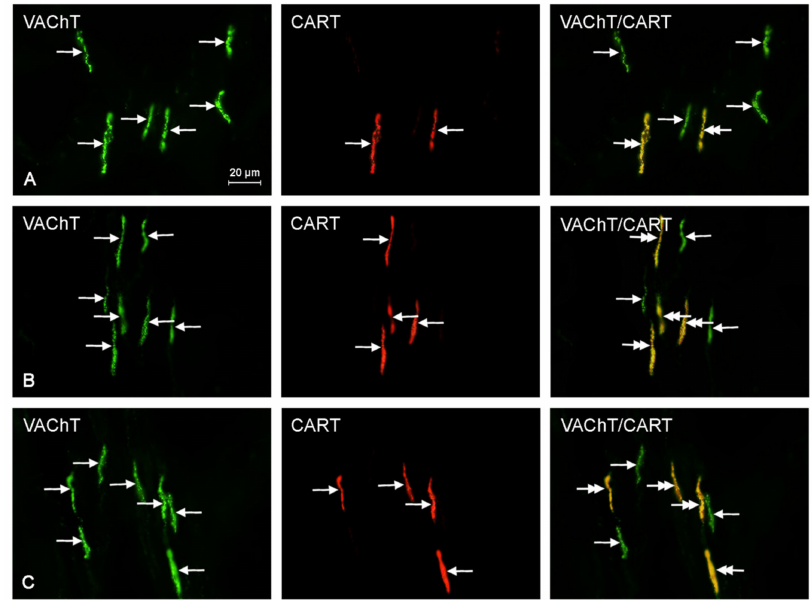
Figure 2. Representative images of immunocytochemical localization of VAChT-, and CART-immunoreactive nerve fibers in intrahepatic sympathetic nerves (arrows) of the control (CTRL; ( A )), E1—experimental group 1 (low dose of bisphenol A; ( B )), and E2 – experimental group 2 (high dose of bisphenol A, ( C )); VAChT or CART-IR nerve fibers are indicated with arrows, VAChT and CART-IR nerve fibers are indicated with double-headed arrows; scale bars in all figures; 20 µ m.